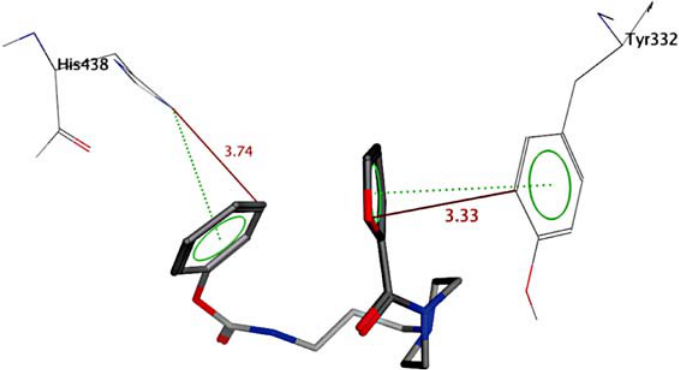
Fig. 7. 3D interacted image of phenyl 3- [ 4-(2-furoyl)-1-piperazinyl ] propylcarbamate ( 12 ) against